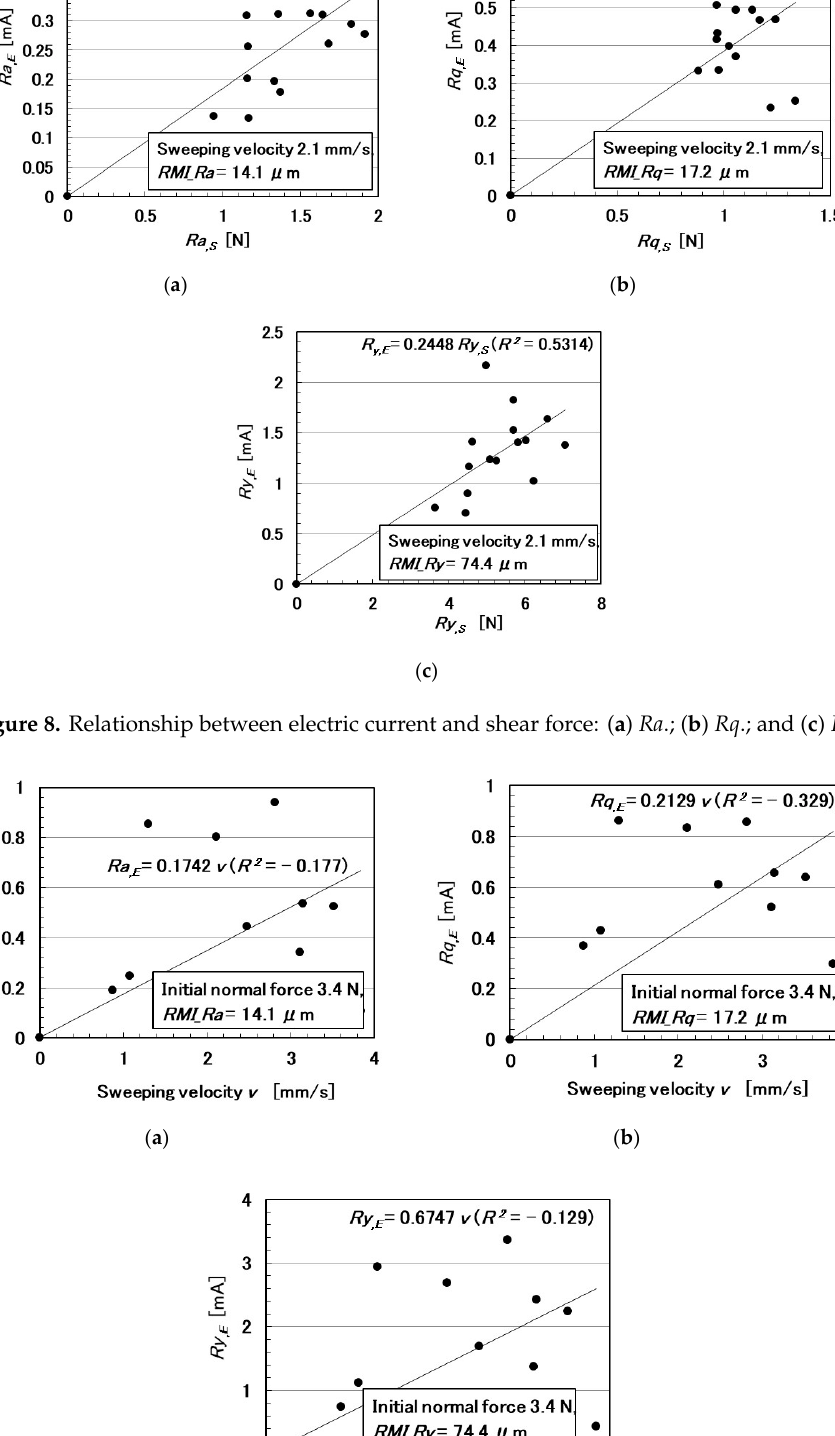
Figure 7. Relationship between electric current and normal force: ( a ) Ra .; ( b ) Rq .; and ( c ) Ry .